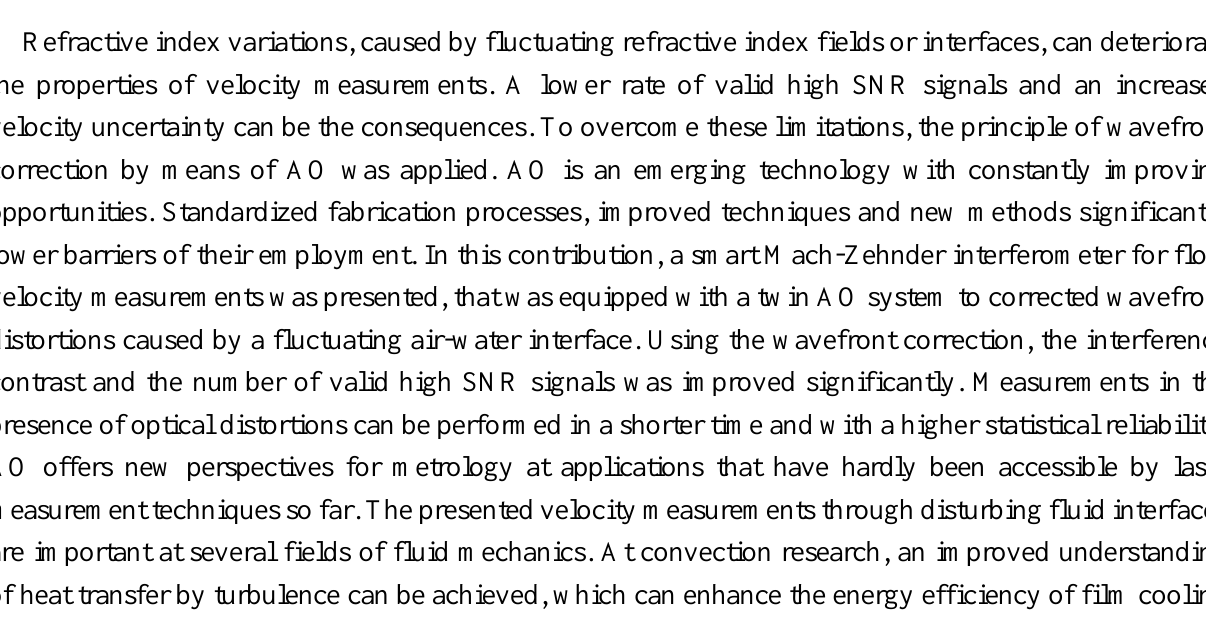
Figure 4. Measurement of the flow profile of a submerged water nozzle by the smart LDV interferometer. The experiments have been conducted for a distortion amplitude, i.e. , mean surface wave height of 50 µm. Both laser beams pass the free water surface, see Figure 1. They are controlled both by an adaptive optics (AO) system using electrically tunable lenses and galvanometer mirrors. ( a ) Profile of the mean velocity with the velocity standard deviation as uncertainty bars. The velocity standard deviation is dominated mainly by the flow turbulence; ( b ) Mean interference contrast; ( c ) mean validation rate and ( d ) confidence interval, all shown as a function of the position alongside the nozzle